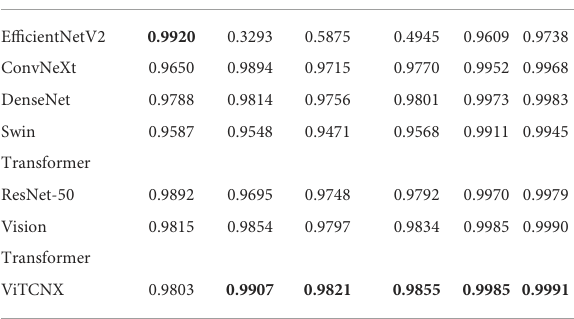
TABLE 1 Performance of ViTCNX and the other six models under the binary classification.